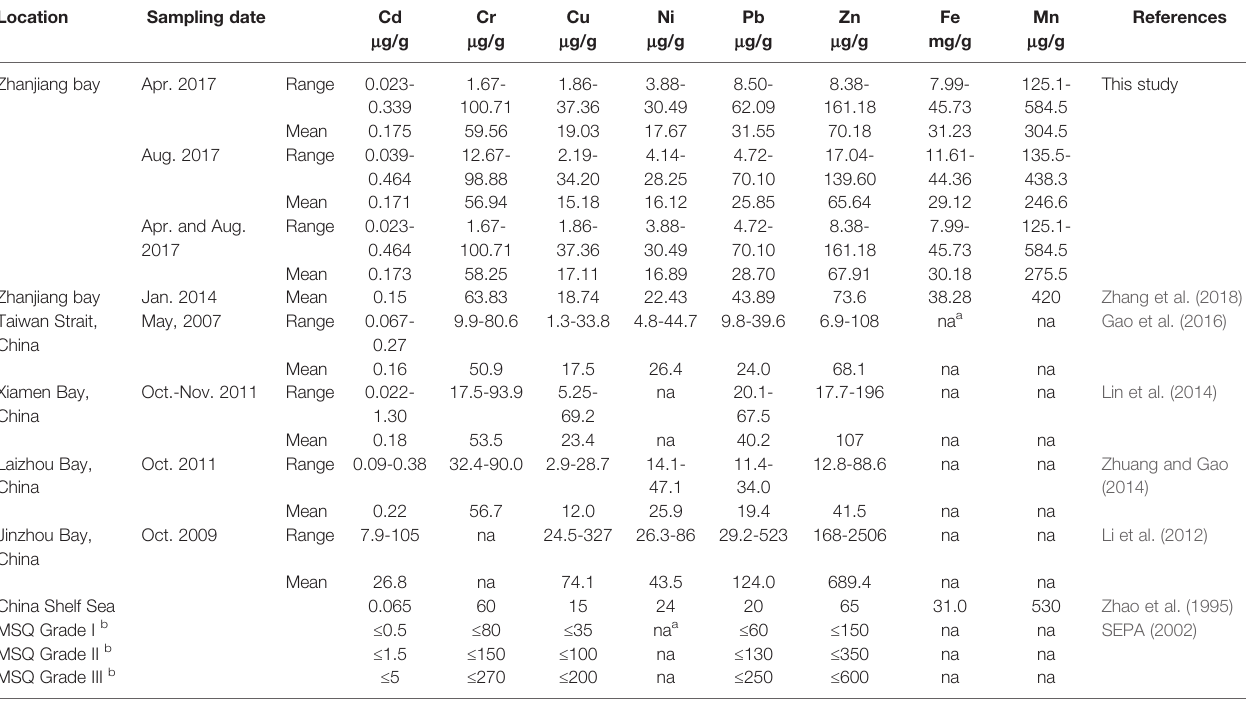
TABLE 2 | Metal concentrations in the surface sediments of ZJB and other coastal areas of China. Related sediment quality guidelines are also shown for comparison purpose.